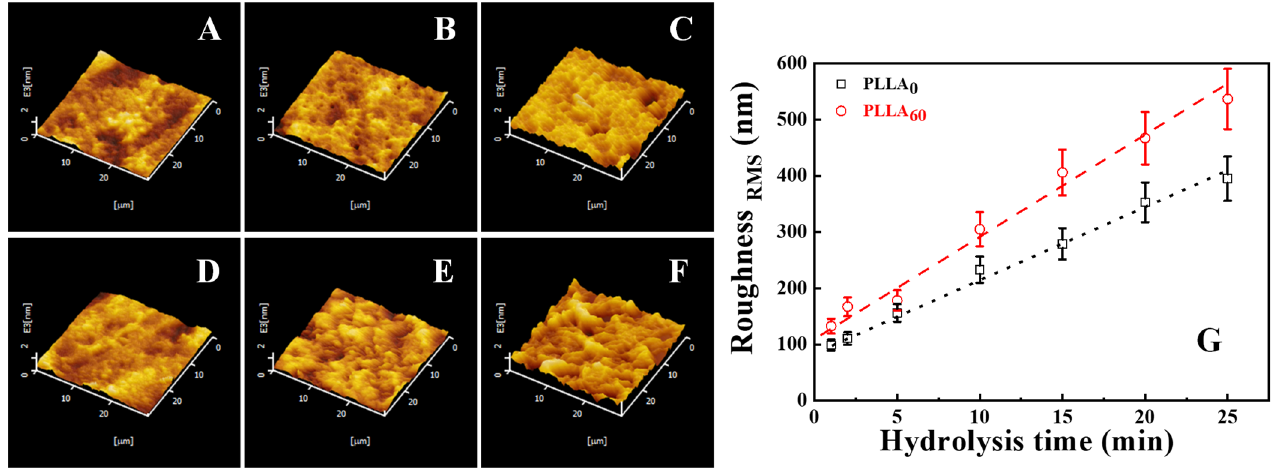
Figure 6. AFM images of modified PLLA membranes: PLLA 0 with alkaline hydrolysis time for 1 min, 5 min and 25 min ( A – C ); PLLA 60 with alkaline hydrolysis time for 1 min, 5 min and 25 min ( D – F ); ( G ) shows the roughness evolution during hydrolysis in PLLA 0 and PLLA 60 .